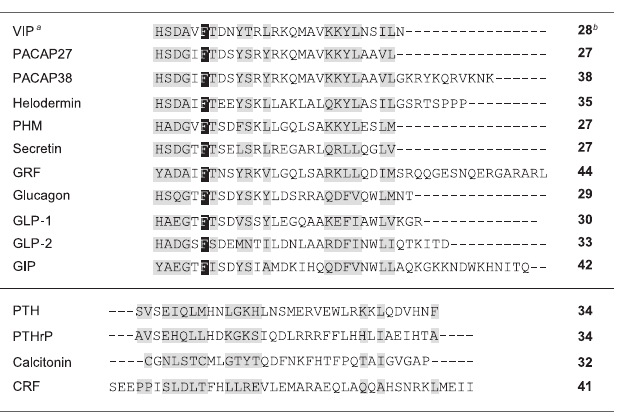
Table 2 | Sequence alignments of class B GPCR ligands b .